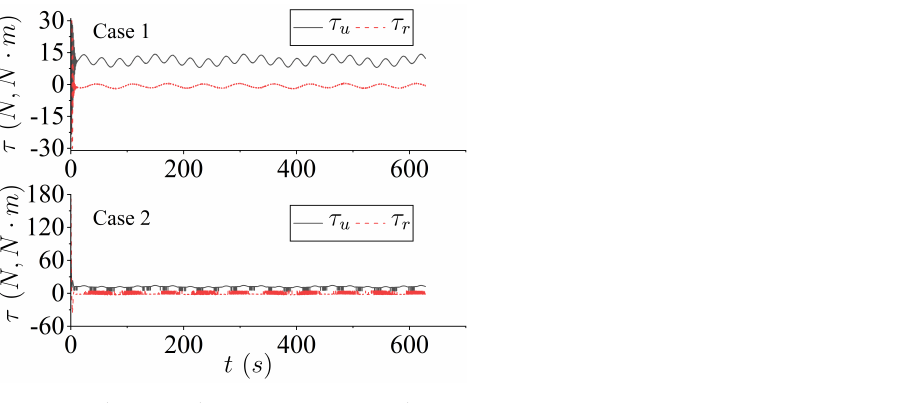
Figure 6. The control inputs in Case 1 and Case